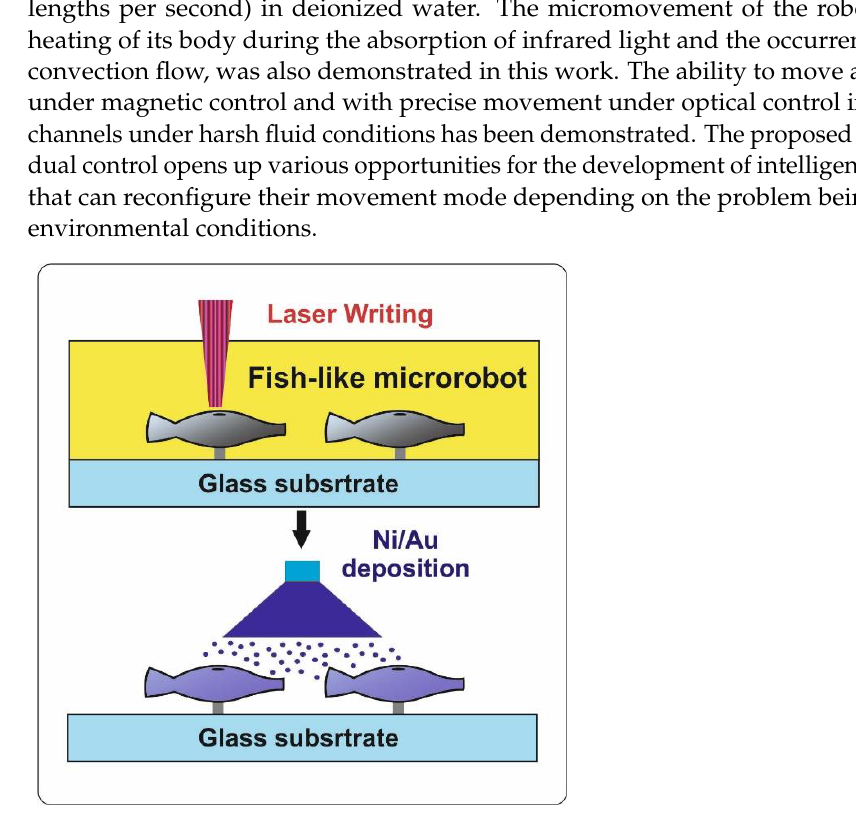
Figure 4. Schematic representation of the manufacturing process of dual-driven biomimetic mi- crorobots.